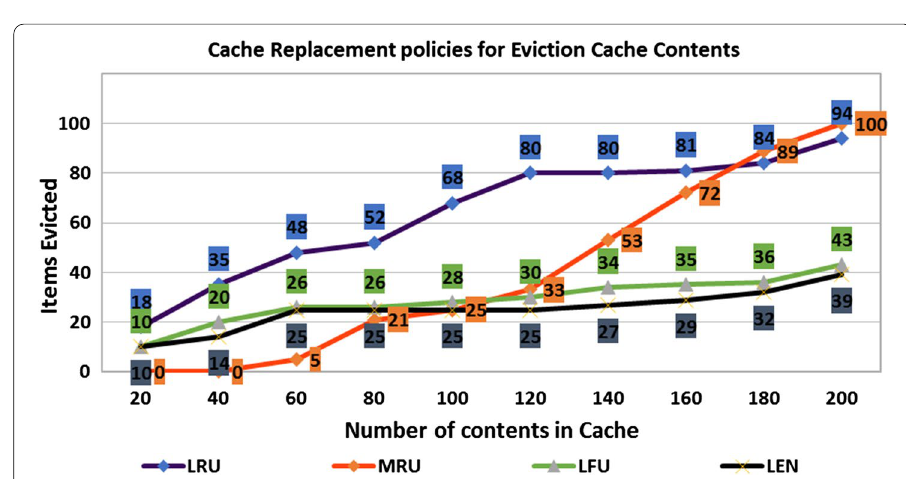
Fig. 5 Eviction SBS cache contents comparison between LRU, MRU, LRU and LEN for different number of SBS cache